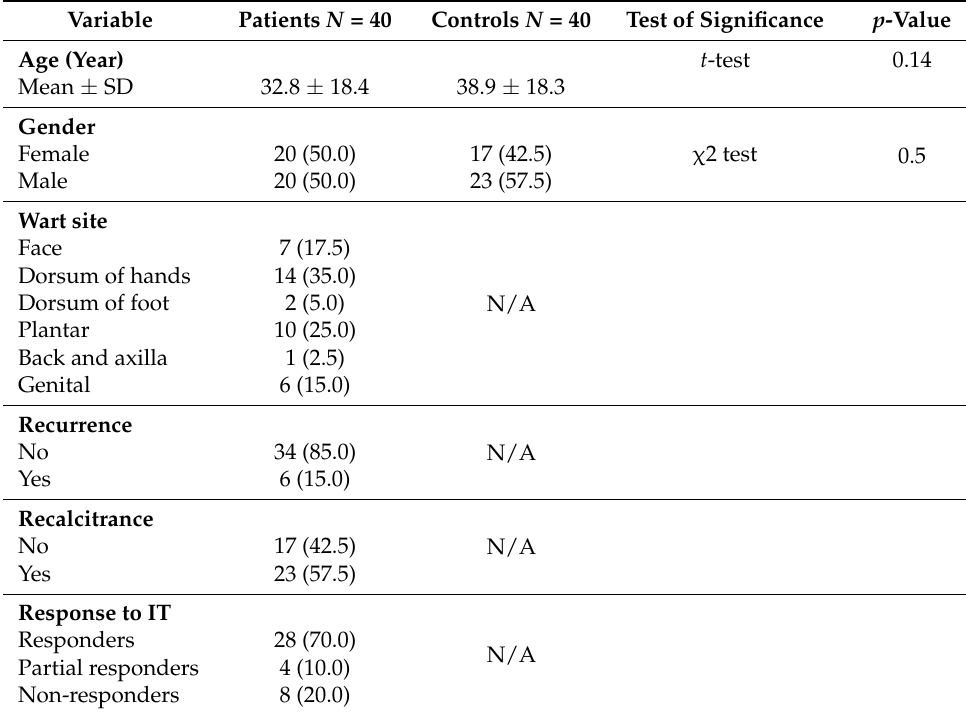
Table 1. Baseline characteristics of the study